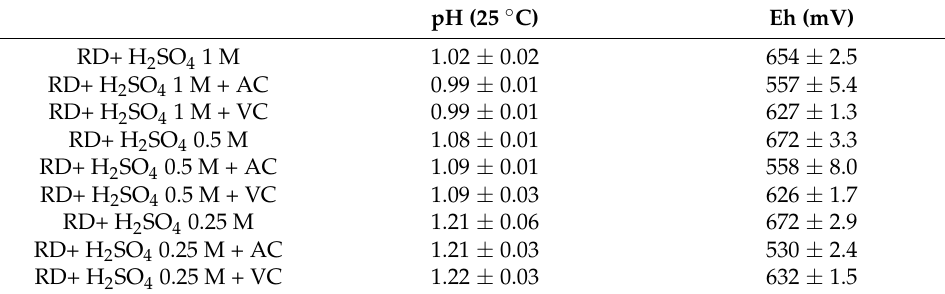
Table 5. pH and Eh (mV) of leaching